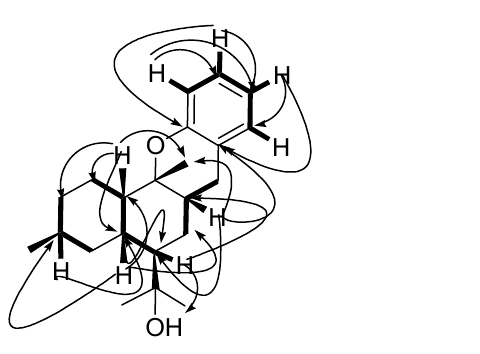
Figure 2. Some key COSY (bold lines) and HMBC (arrows) correlations for cleistonol ( 1 ).